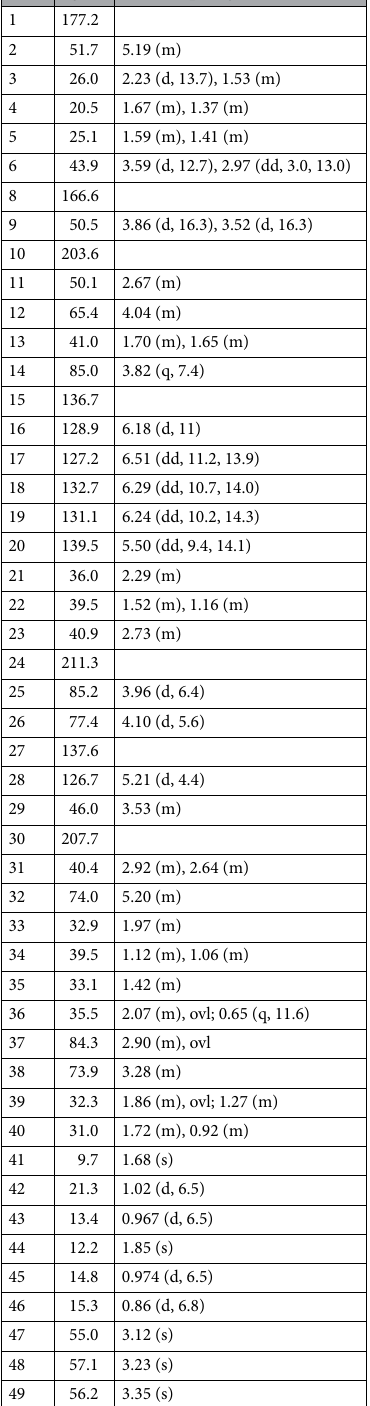
Table 1. 13 C and 1 H NMR spectroscopic data for 1 in acetone- d 6 (150/600 MHz,